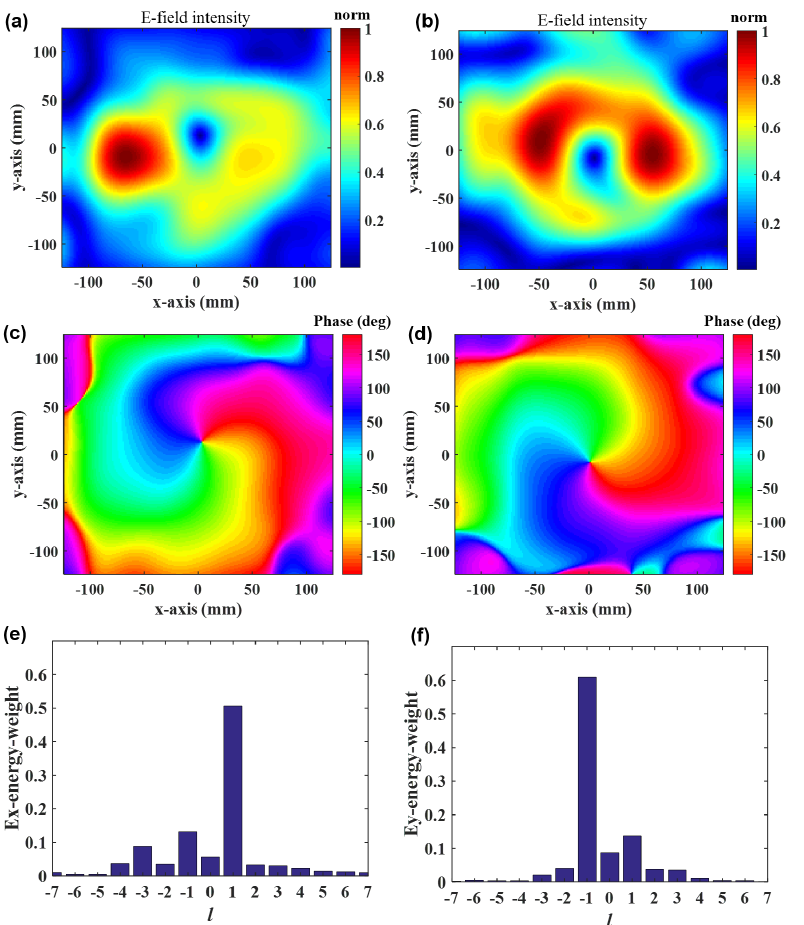
Figure 5. Near-field observation and corresponding spectral analyses at the plane of z = 414 mm with a dimension of 248 mm 248 mm. ( a ) Normalized electrical intensity distribution in x direction under y polarization (TE wave). ( b ) Normalized electrical intensity distribution in x direction under x polarization (TM wave). ( c ) Phase of y-polarization component Ex. ( d ) Phase of x-polarization component Ey. ( e ) Histograms of the simulated OAM spectrum weight for OAM mode number l = + 1. ( f ). Histograms of the simulated OAM spectrum weight for OAM mode number l = −